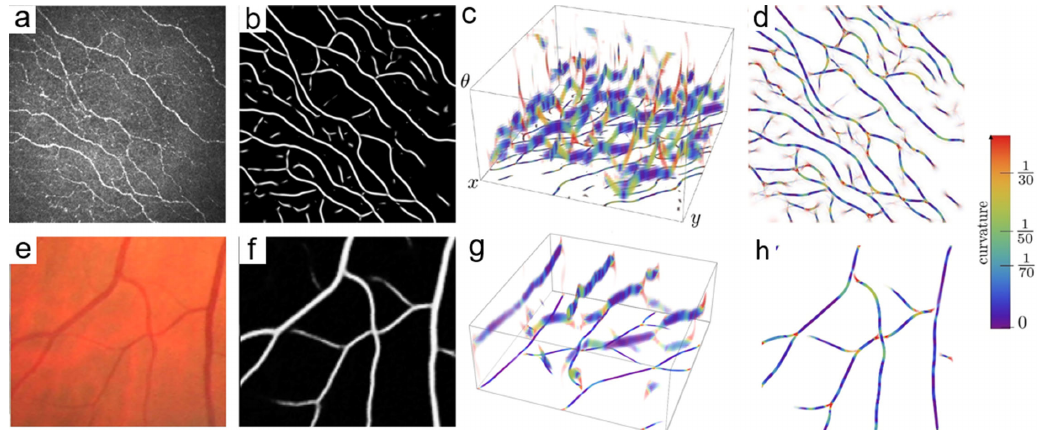
Figure 2. Overview of the proposed exponential curvature estimation on corneal nerve fibers and retinal vessels: ( a ) nerve fiber image; ( b ) enhanced nerve fiber image; ( c ) nerve fiber curvature map in 3D orientation score space with color-coded; ( d ) nerve fiber curvature map in the 2D space; ( e ) vessel image; ( f ) enhanced vessel image; ( g ) 3D vessel curvature map; ( h ) 2D vessel curvature